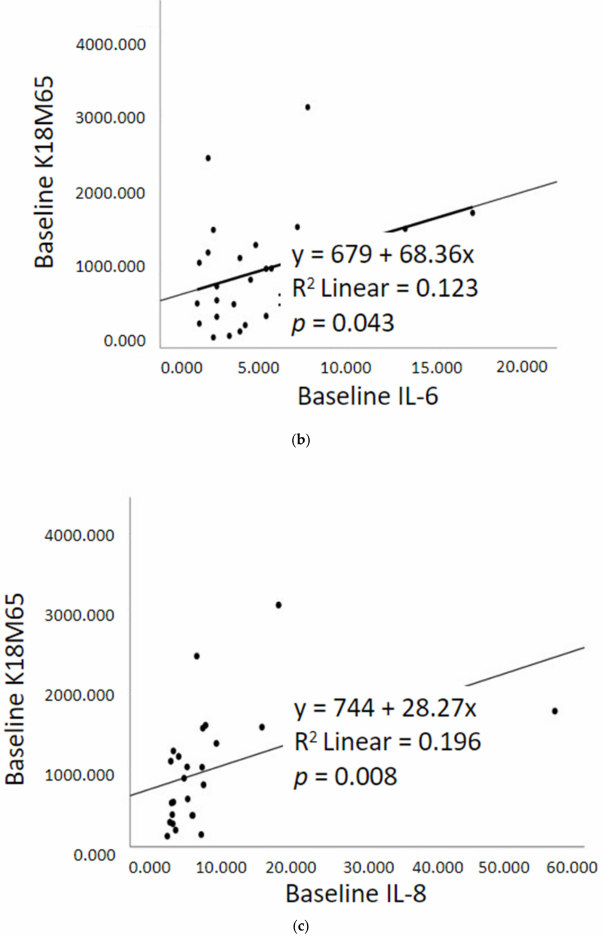
Figure 5. Univariate regression analyses of cytokines with K18M65 within Gr.2—AUD patients with fibrosis ( a ) K18M65 compared with baseline TNF- α ; ( b ) with baseline IL-6; and ( c ) with baseline